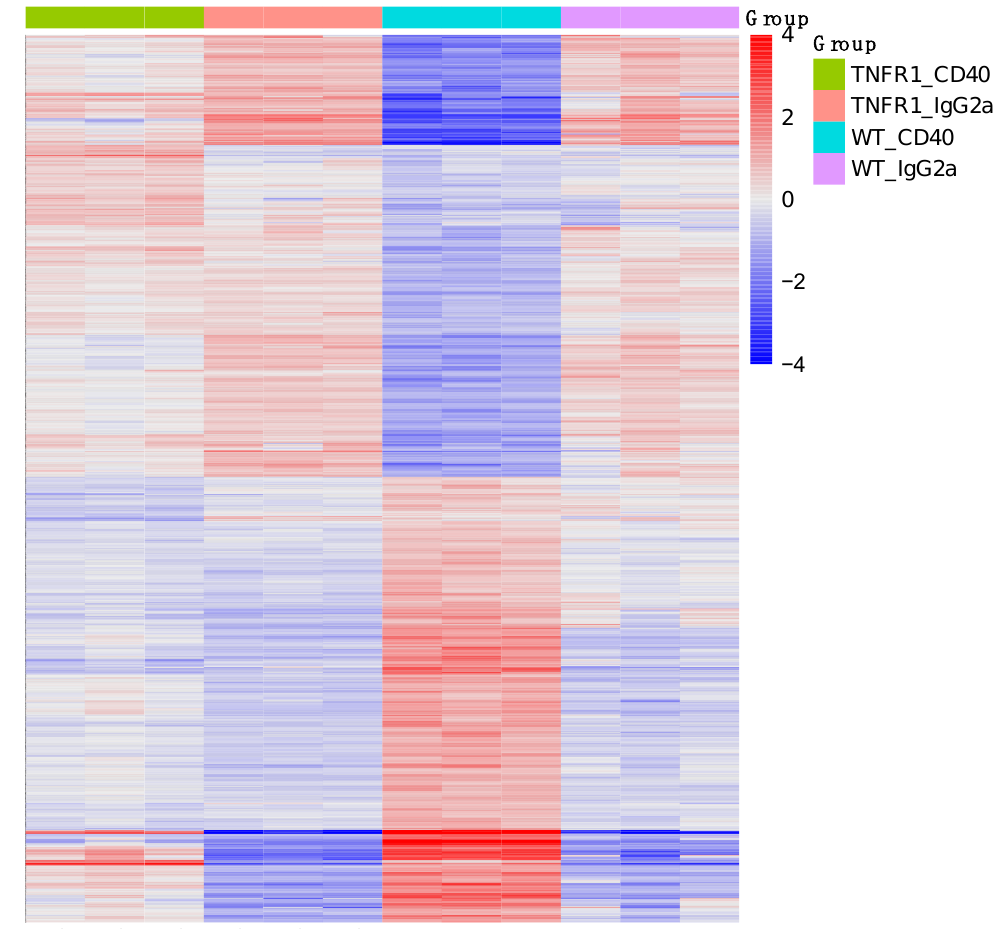
Figure 2. Heat map of the differential expression array of over-expressed (red) and under-expressed (blue) genes (Table 1) in TNFR1 −/− mice treated with CD40 mAb (green) relative to wt mice treated with CD40 mAb (turquoise). Orange color depicts TNFR1 −/− mice, and violet color wt mice, treated with the control IgG2a, respectively. Table 1. Top 10 KEGG pathways in CD40 mAb-stimulated TNFR1 −/− and wt mice.